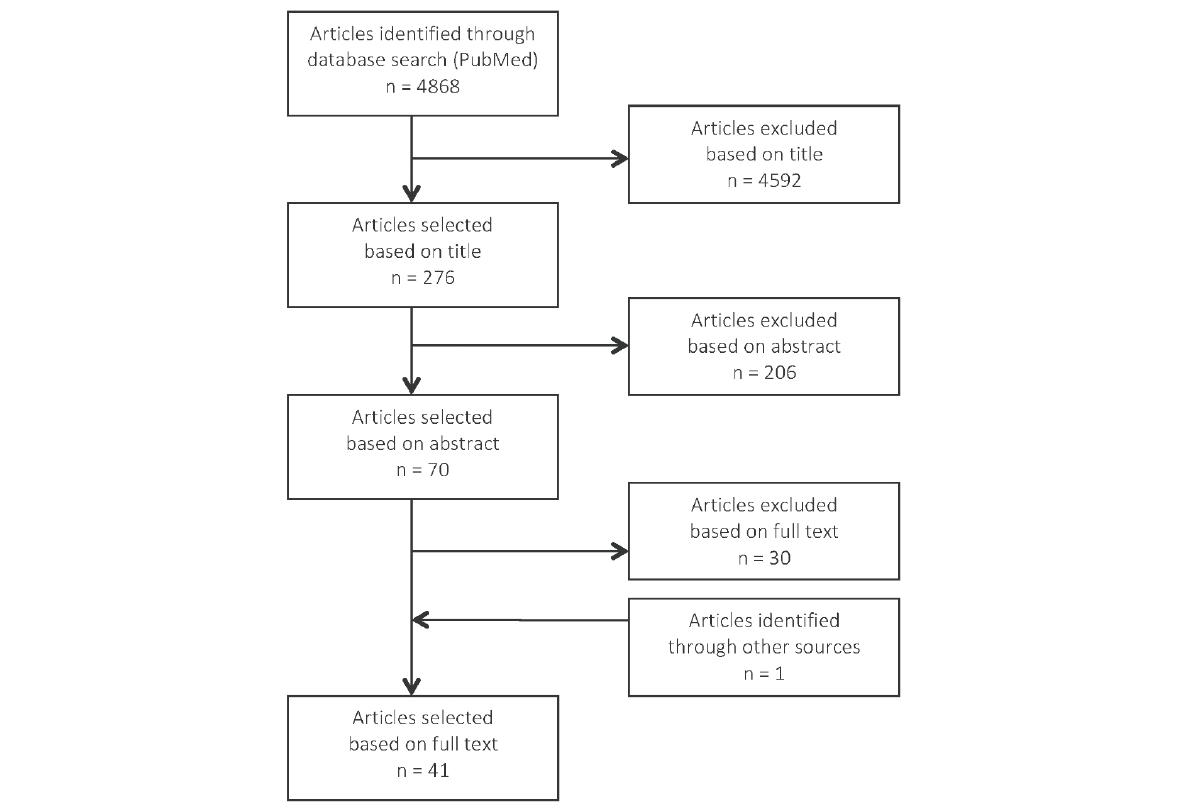
Figure 1. Flowchart of study selection